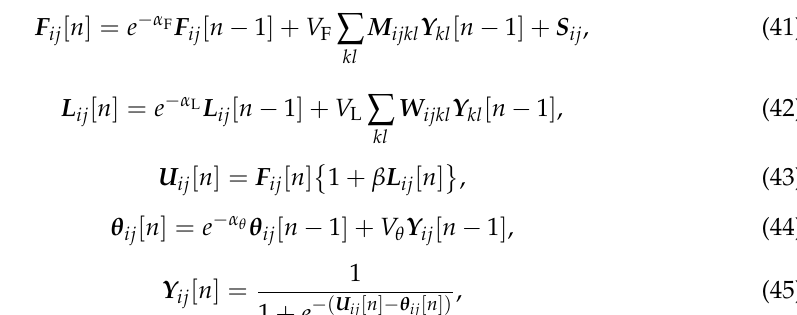
Figure 4. Structure of group-linked HSPCNN.